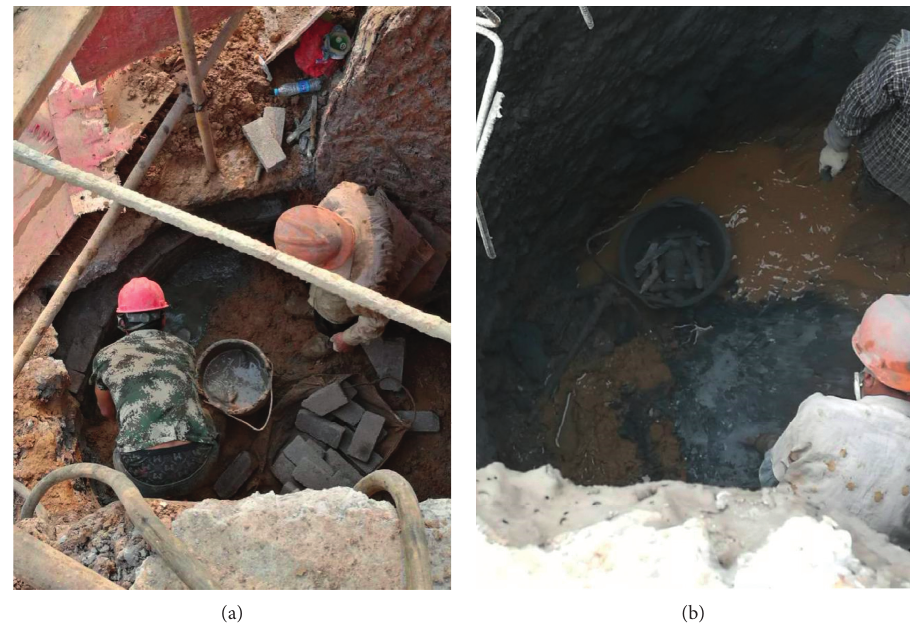
Figure 16: Photos taken from the excavation site. (a) The temporary lining and (b) the exposed reinforcing